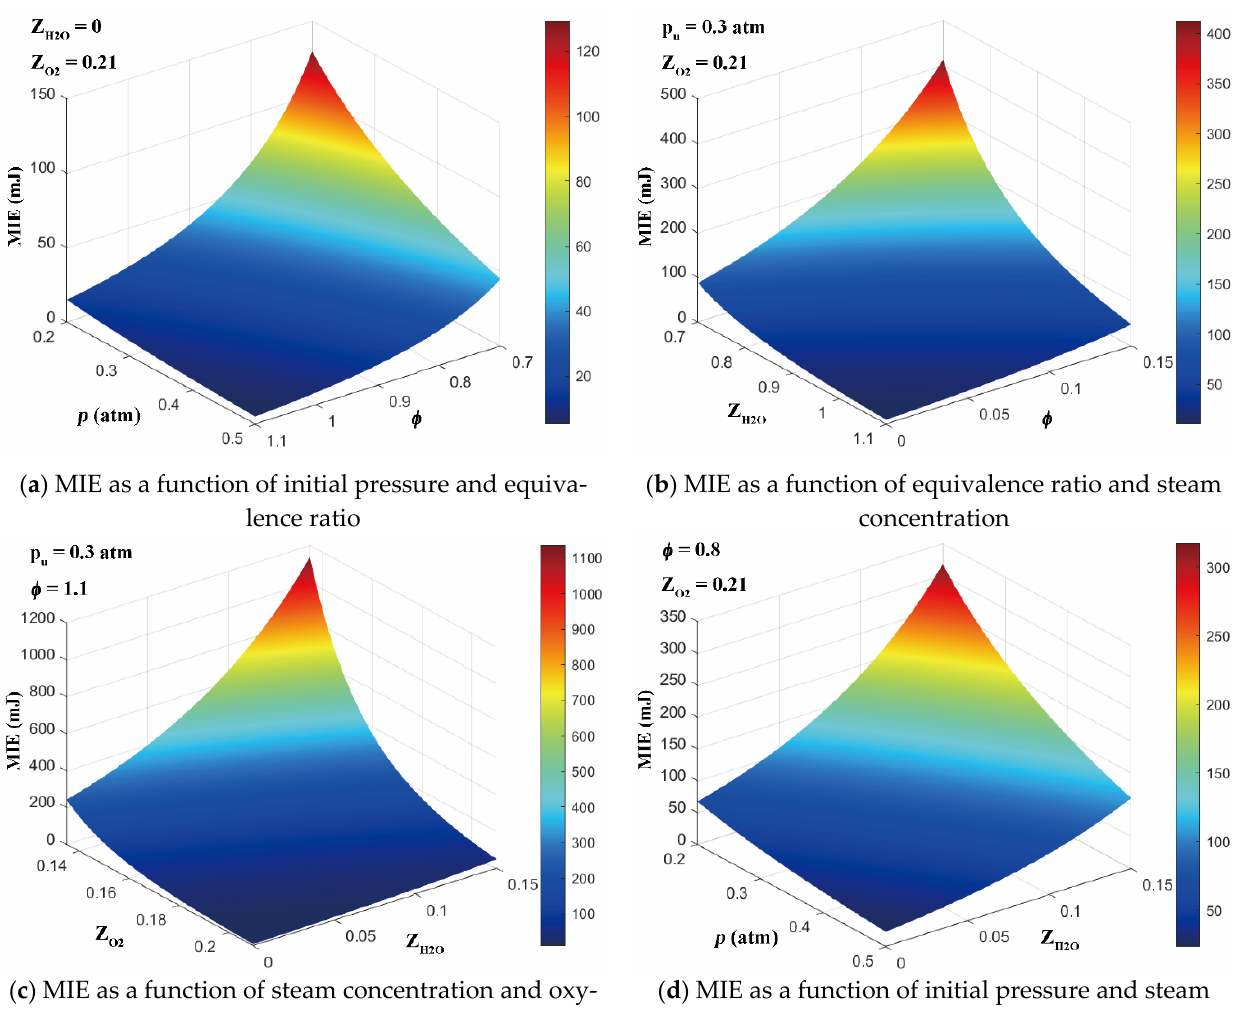
Figure 10. Comparison between the calculated results and the experimental results of MIE.